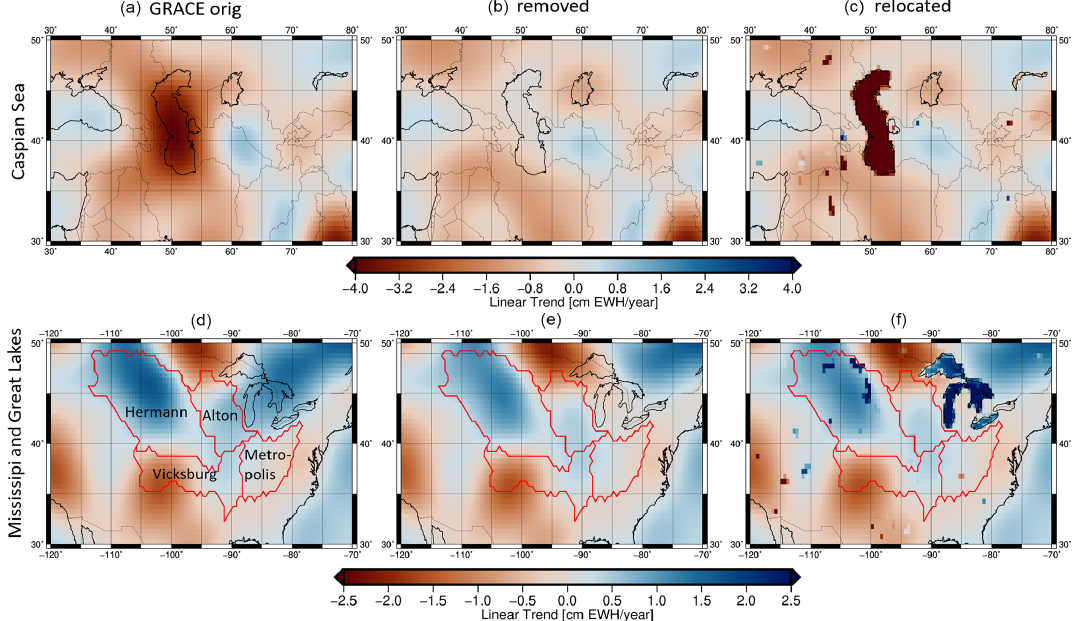
Figure 6. Linear trend of GRACE TWS anomalies (January 2003–December 2016) in the Caspian Sea region (a–c) and in the Mississippi Basin and around the Great Lakes (d–f) without any correction (a, d) , after removing the influence of lakes (b, e) , and after relocating the lake signal (c, f) . Please note that the Aral Sea has been excluded from RECOG-LR RL01 due to its strongly varying surface area, which is not yet captured in the